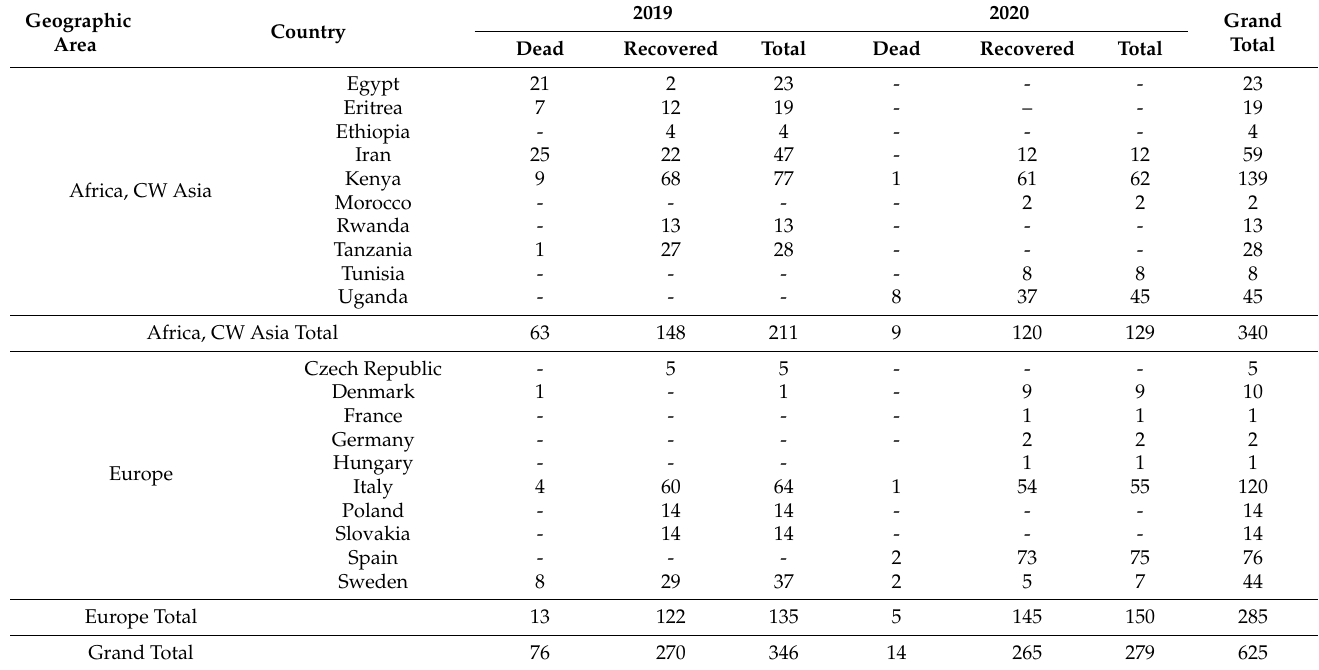
Table 2. Stem rust samples preserved in Global Rust Reference Center (GRRC) in Denmark according to Hovmøller et al.